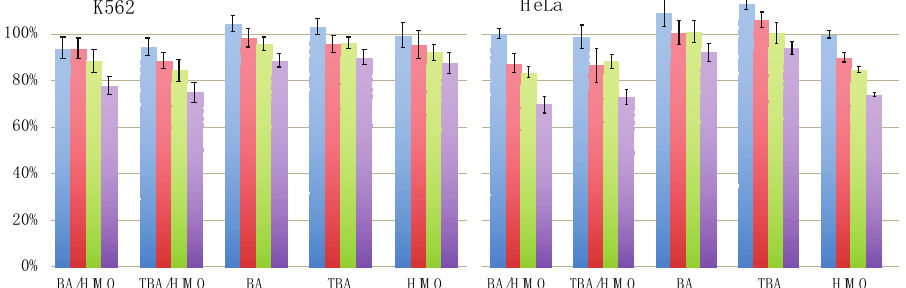
Figure 16. The viability (%) of K562 and HeLa cells after 48 h incubation with the tested compounds in a concentration range from 1 µ M (blue bar) to 10 µ M, 50 µ M and 100 µ M (red, green violet bars) respectively. The results represent the mean ± standard error.